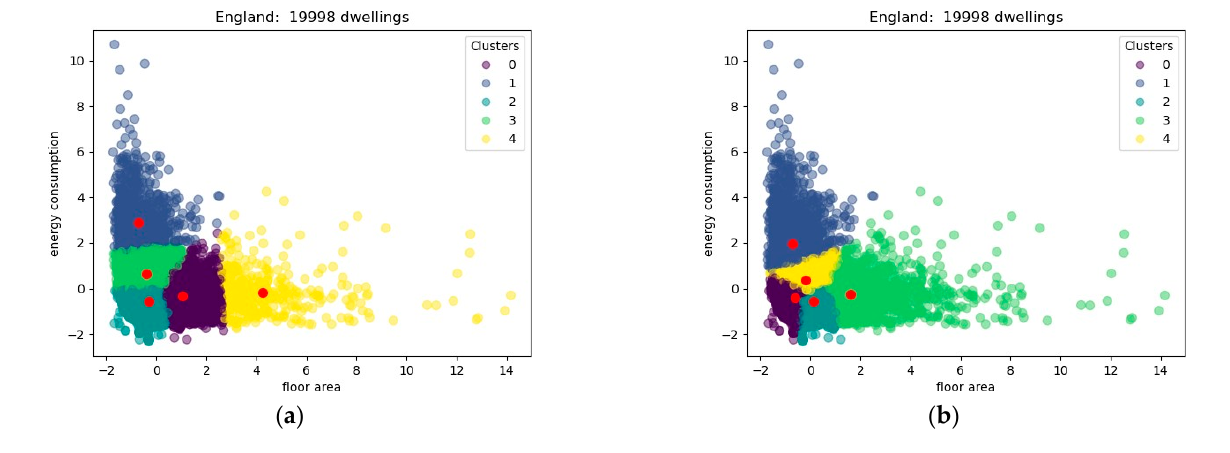
Figure 4. ( a , b ): Clustering methods for England (k = 5). Table 6. Effectiveness metrics for England.